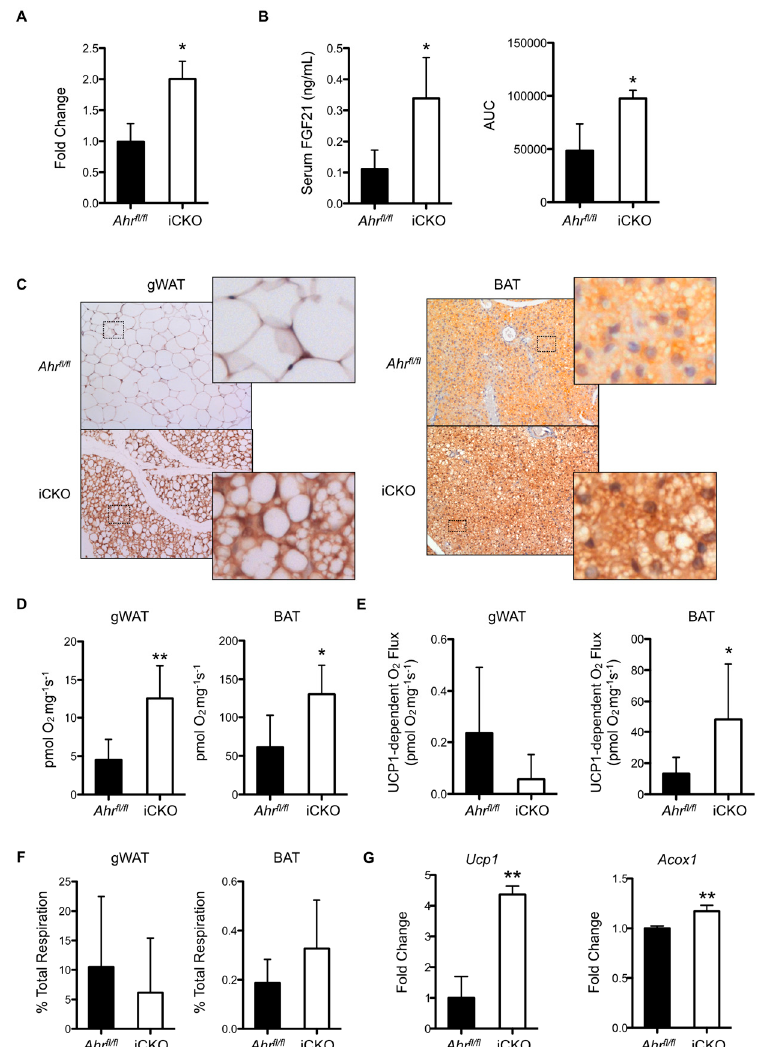
Figure 3. Tamoxifen-induced loss of hepatic AHR expression is associated with increased hepatic FGF21 production and gWAT/ brown adipose (BAT) thermogenesis. ( A ) Fgf21 mRNA and ( B ) serum FGF21 concentrations as measured by ELISA (left) or Selected Reaction Monitoring mass spectrometry (right) are elevated in iCKO mice ( n = 3–5 per genotype) at 1 week post-tamoxifen administration. ( C ) Immunohistochemical staining for uncoupling protein 1 (UCP1) is more intense in gWAT and BAT from iCKO mice at 1 week post-AHR loss, and reveals increased multilocular lipid droplet formation. ( D ) Total respiratory capacity in gWAT and BAT is significantly increased in iCKO mice five weeks after tamoxifen treatment ( n = 6 per genotype). ( E ) Absolute UCP1-dependent respiration is modestly lower in gWAT, but significantly greater in BAT. ( F ) UCP1-dependent respiration as a percentage of total respiration. ( G ) iCKO mice exhibit significantly greater Ucp1 and Acox1 gene expression at five weeks post-tamoxifen treatment. All microscopy images are shown at 200 × magnification and are representative of three animals. Areas enclosed by a dashed rectangle have been digitally zoomed and shown in the corresponding inset for clarity. Numerical data are presented as mean ± SEM. Statistical analyses were performed using a Student’s t test, with significant differences indicated as * p < 0.05 or ** p <